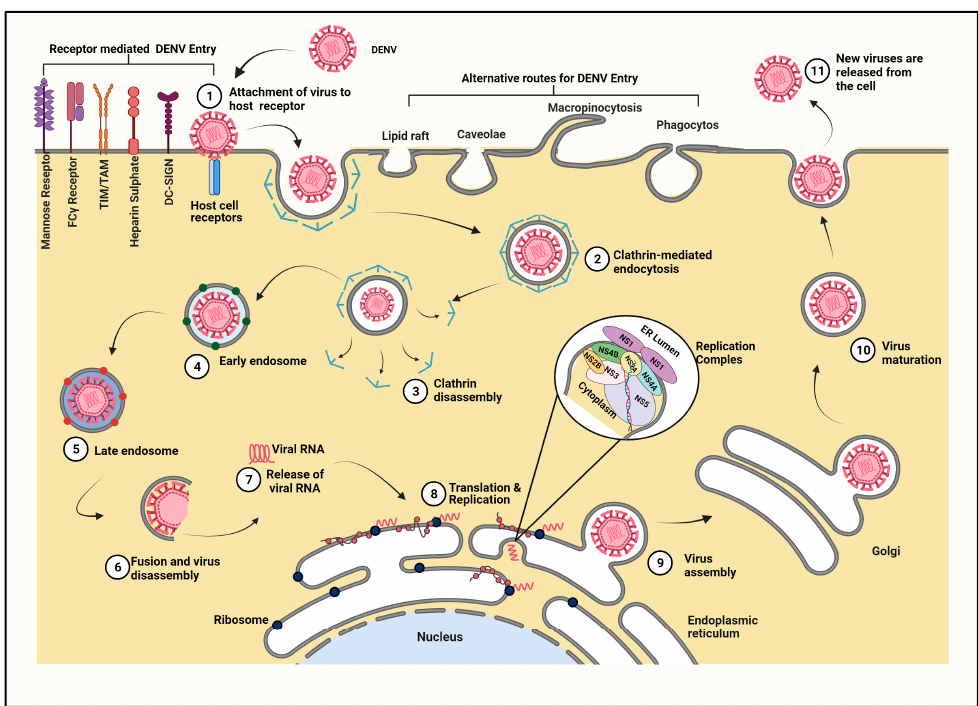
Figure 2. Replication cycle of Dengue virus: The replication cycle begins with entry into the host cell that initiates from binding of the virus to host cell receptors. (1) The DENV bind can host various receptors to enter via receptor-mediated endocytosis, while alternative routes of entry are described too. Most studied and reported, clathrin-mediated endocytosis is described hereafter. (2) The clathrin-coated pit serves as the site of internalization, and the virus is endocytosed into a perforated bubble coated with clathrin. (3) Further, the clathrin is released, initiating endosomal processing. (4) The early endosome is marked by presence of the Rab5 protein (green solid spheres) where pH is around 6.5, which proceeds towards endosome maturation. (5) The mature endosome is marked by Rab7 (red solid spheres) and at a lower pH, i.e., around 5.5, this acidic pH leads to various conformational changes. (6) The conformational changes cause fusion of the viral envelope and host membrane. (7) The disassembly of the virus results in the release of the encapsidated viral genome (capsid-bound RNA) into the cytoplasm. (The mechanism of uncoating the viral genome is unclear and thus not described in the figure.) (8) The viral RNA serves as a template for translation and replication in the ER. The special sight for replication, formed by convolution of the ER membrane in the presence of NS proteins is called the Replication complex. (9) The replicated genome and translated viral proteins are assembled, forming an immature virus particle in the ER. (10) This immature virus undergoes furin-mediated maturation in the Trans-Golgi Network (TGN). (11) The mature virus is then exocytosed from the infected cell, completing the infection cycle.